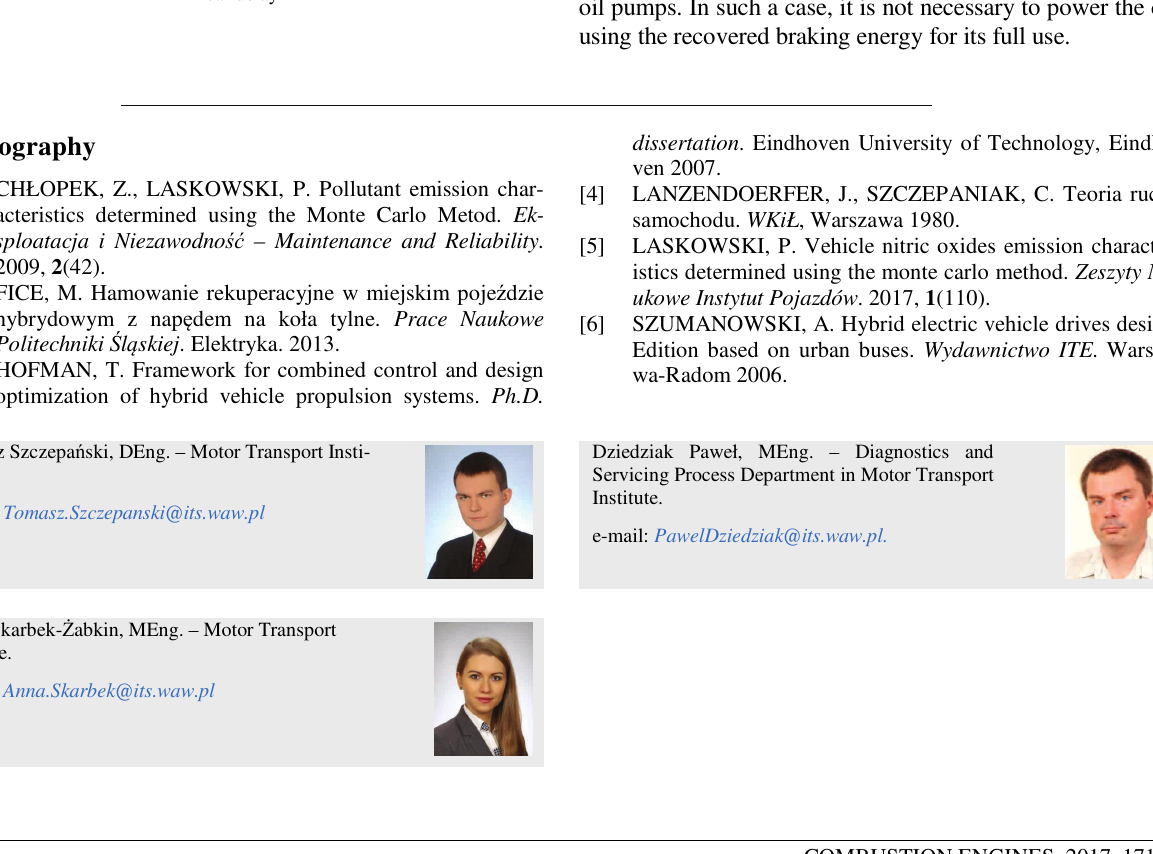
Fig. 11. The average braking power decreased by the movement resistance power as the function of the product of the average speed and the average car